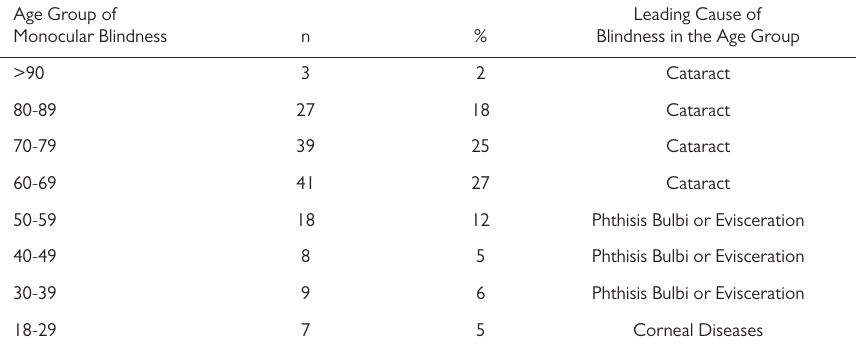
Table 6. The distribution of leading cause of monocular blindness in the age group Age Group